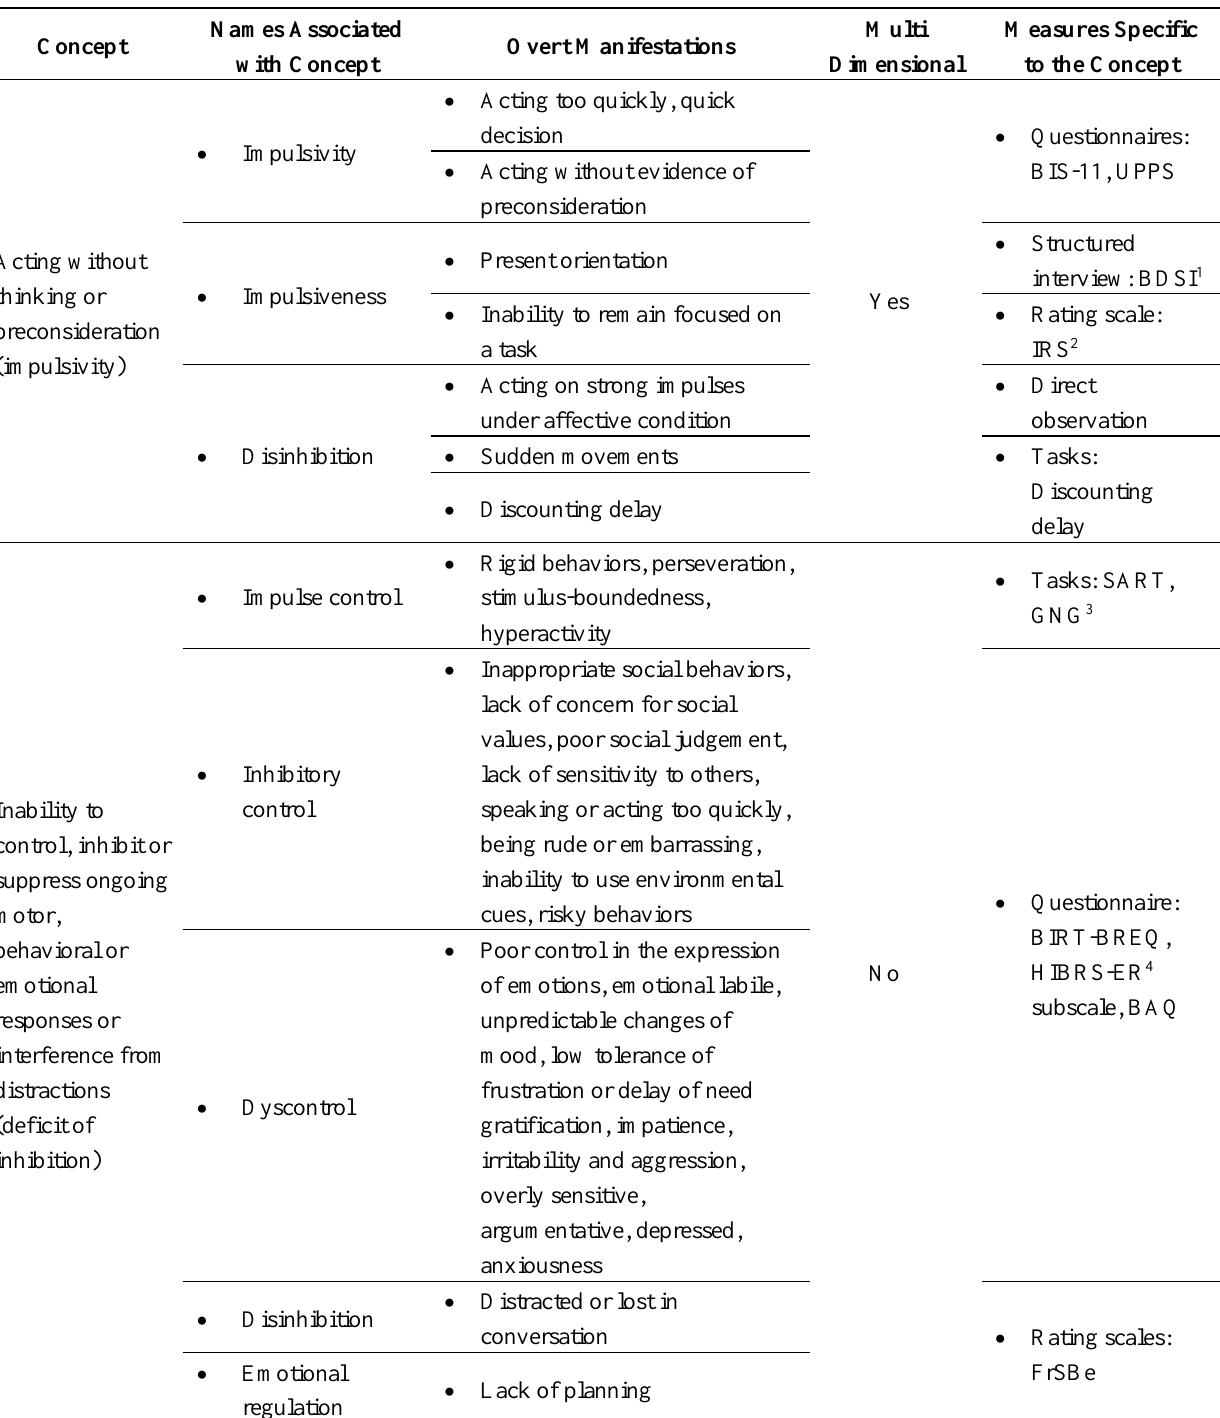
Table 1. General concepts related to post-TBI